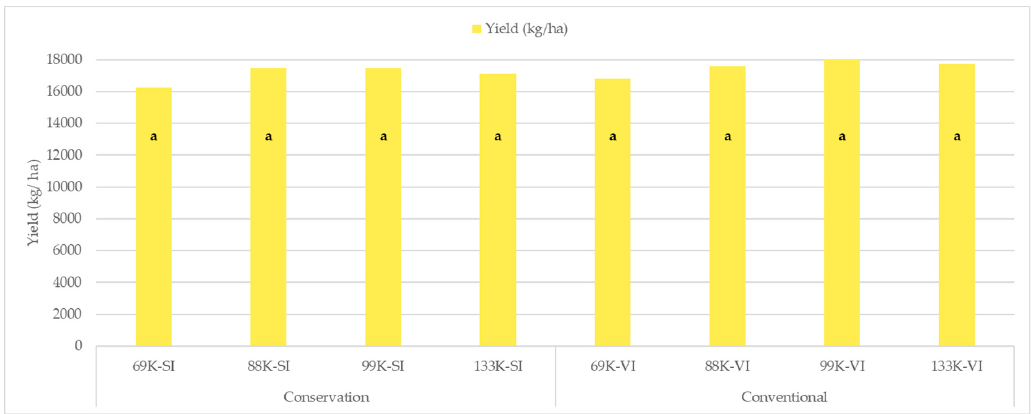
Figure 12. Three years’ average yield (kg/ha) produced in RDC field by each treatment and statistical analysis results.